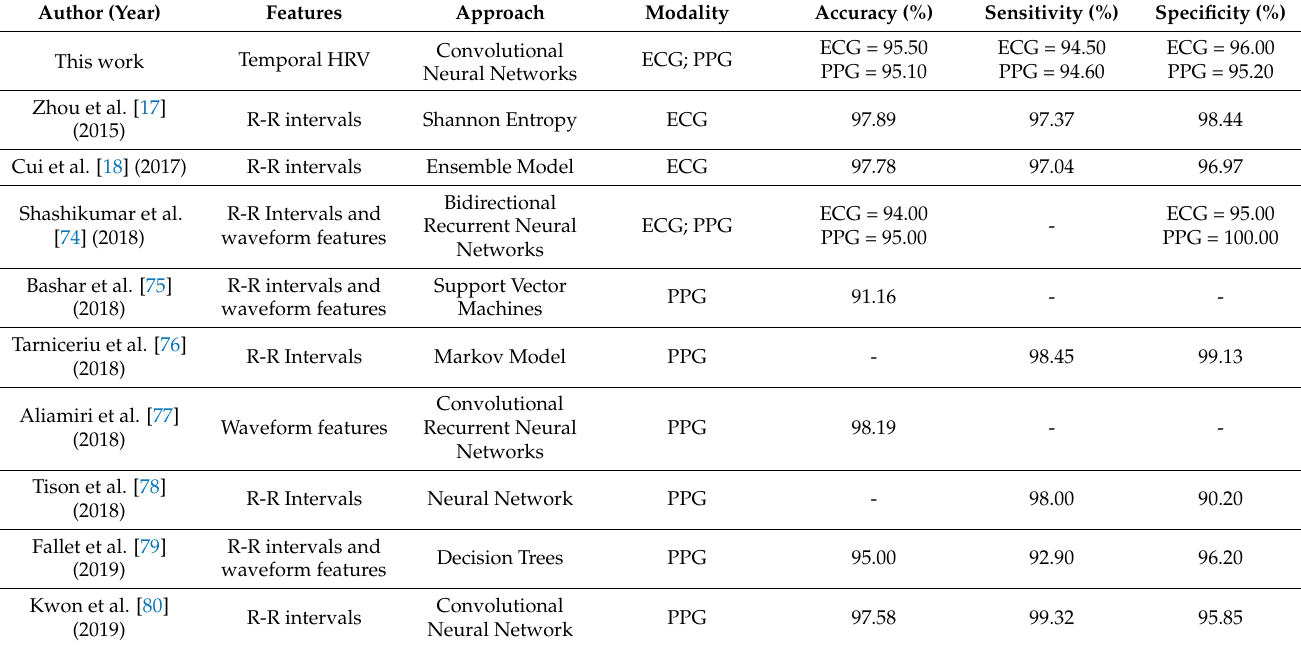
Table 9. A comparison of recent works developed for CVD detection with machine learning and portable